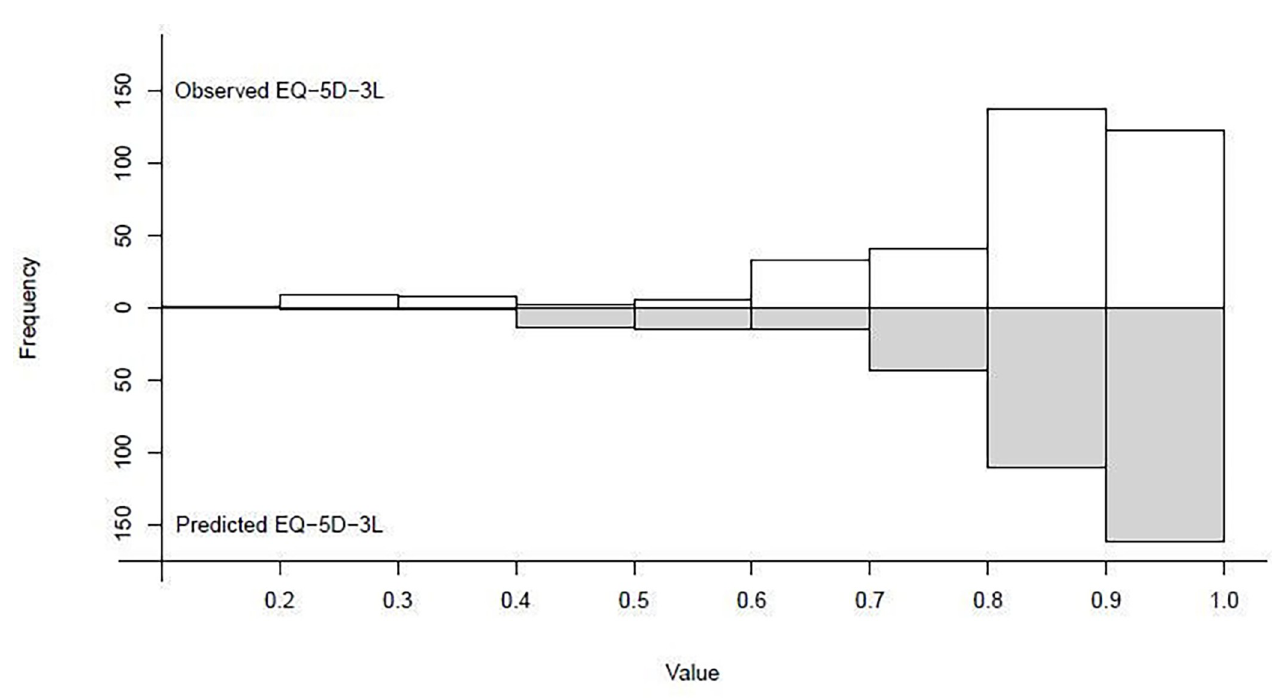
Fig 3. Mirrored histogram of observed and predicted EQ-5D-3L values.